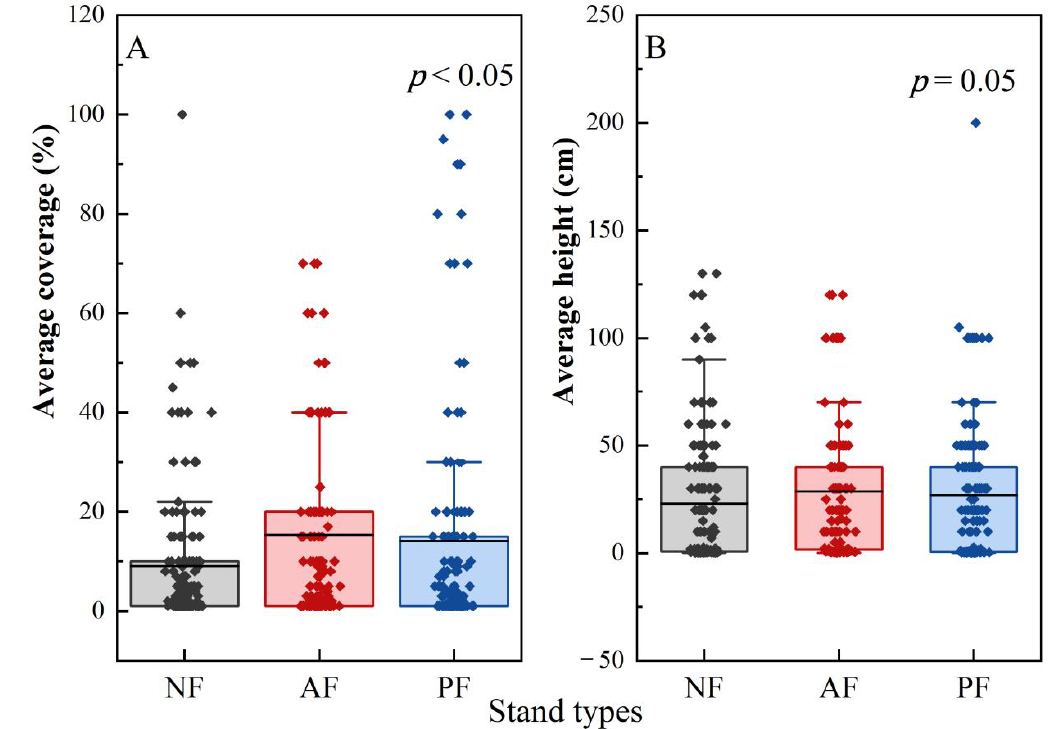
Figure 2. Box and whisker plots showing variations in average cover ( A ) and average height ( B ) of the resident community across stand types. NF = natural forest; AF = abandoned fallows; PF = planted forest.